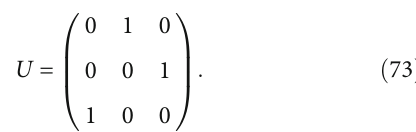
Table 2: Bounds (15), (27), (41), and (57) for di ff erent choices of f and g in